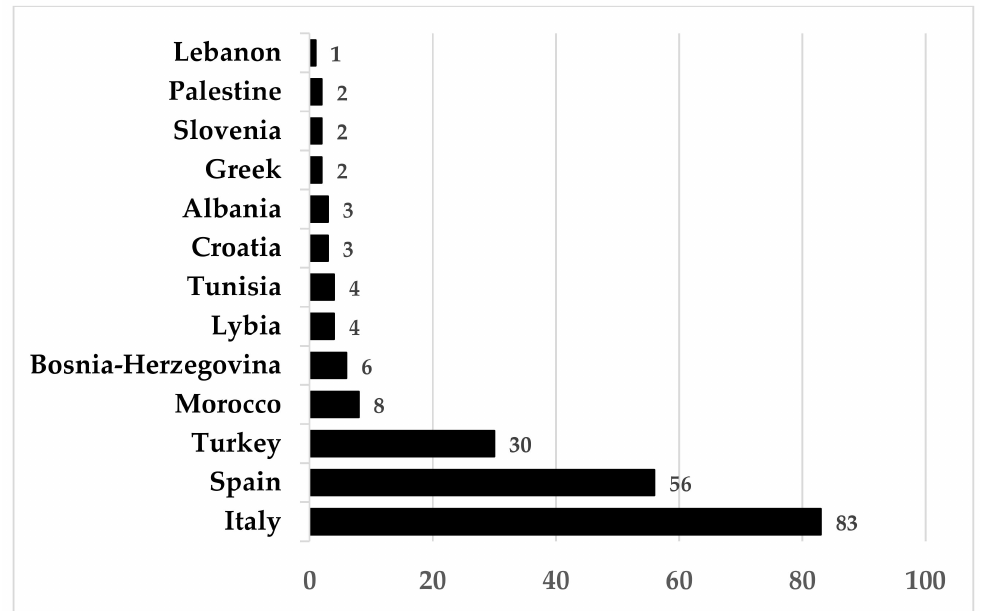
Figure 2. Number of edible flower species used for each Mediterranean